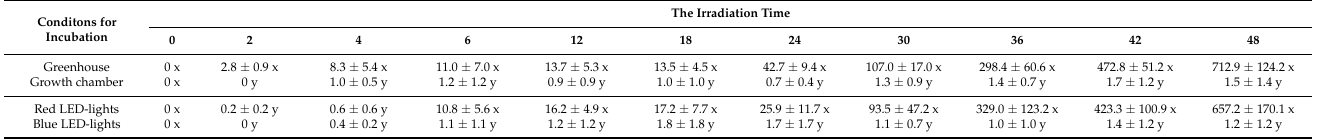
Table 1. Number of progeny conidia collected from single Podosphaera xanthii (Schlechtend.:Fr.) Pollacci KMP-6N colonies using an electrostatic spore collector (insulator plate).